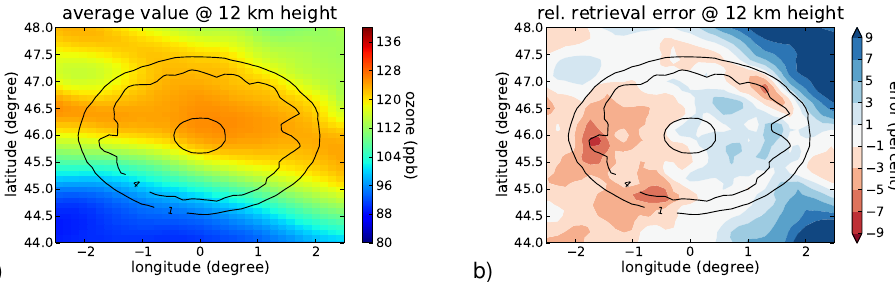
Fig. 16. The atmospheric state averaged over time in panel (a) and the relative error of the retrieval result without wind compensation in relation to the averaged state in panel (b) . The number of tangent points within the volume element is overlaid as a contour plot.